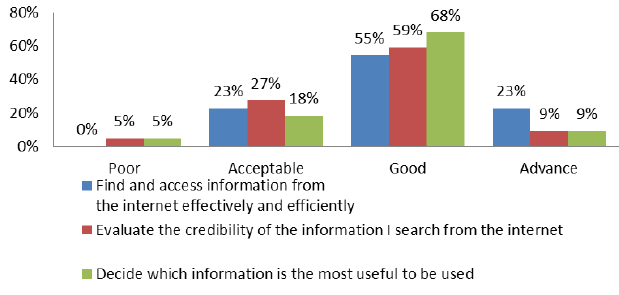
FIGURE 4 | Students’ Information Literacy Skill